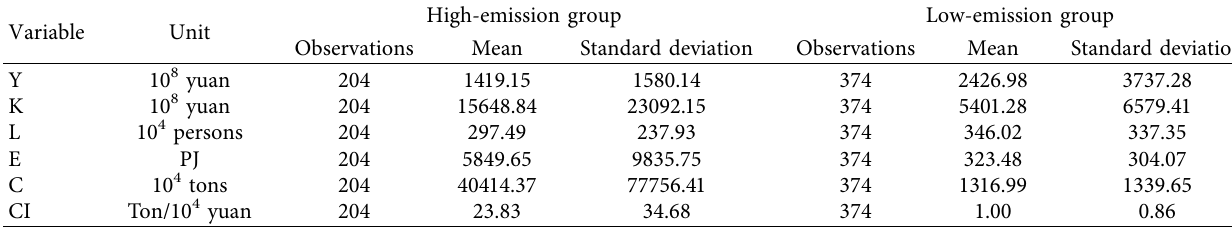
Table 2: Statistical description of main variables.